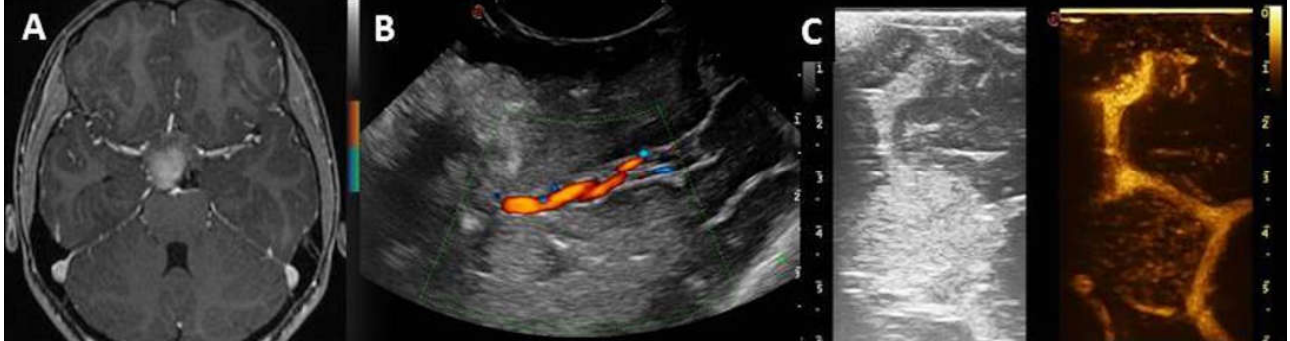
Figure 2. Axial T1-weighted MR after contrast administration showing diencephalic low-grade glioma ( A ). Although the spatial relationship of the tumor with the vessel of Willis circle could be explored through echo-color-Doppler mode ( B ), IOUS post-UCA administration provides a better and more easily interpretable picture ( C ).